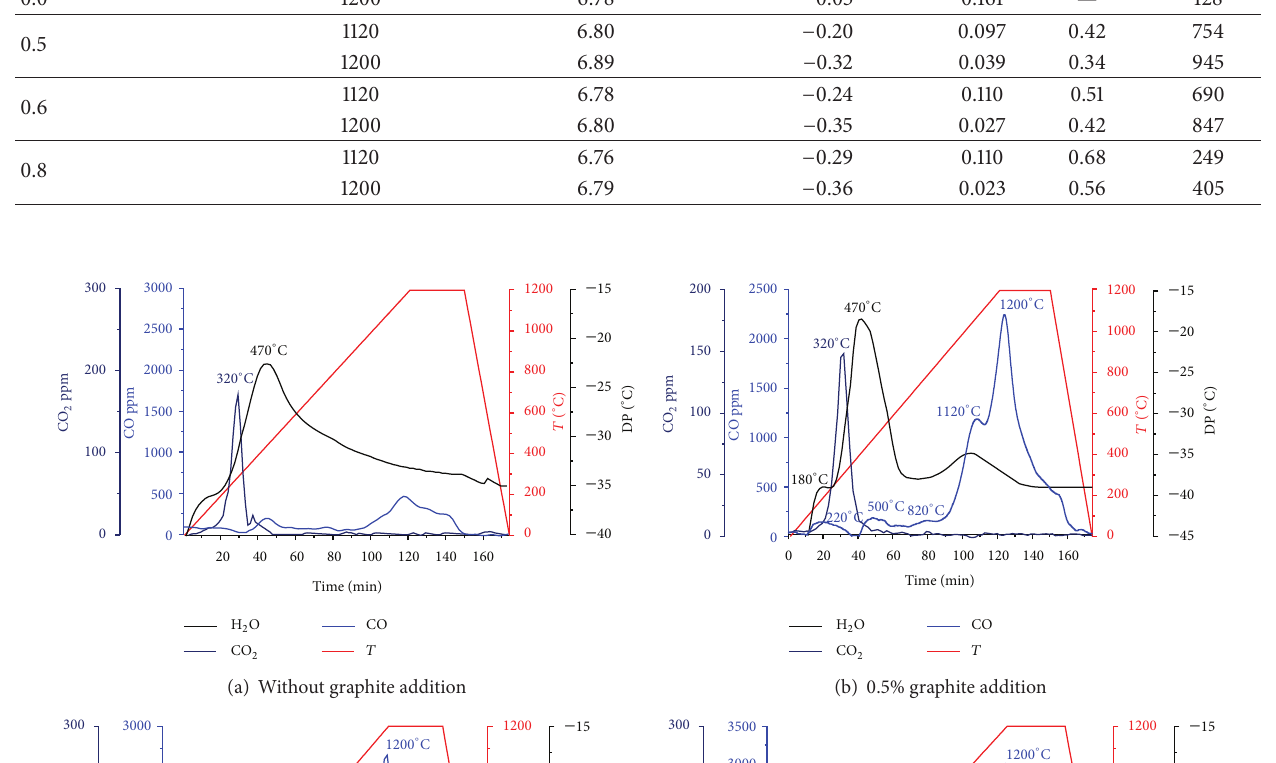
O, CO , and CO peaks in relation to graphite addition; AstCrM + C material with the density of 6.8g/cm 3 2 2